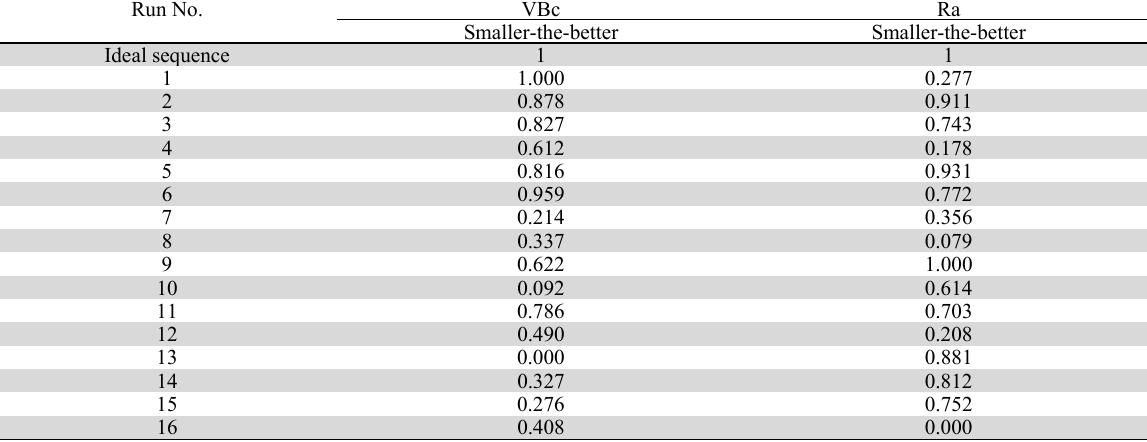
Grey relational generation